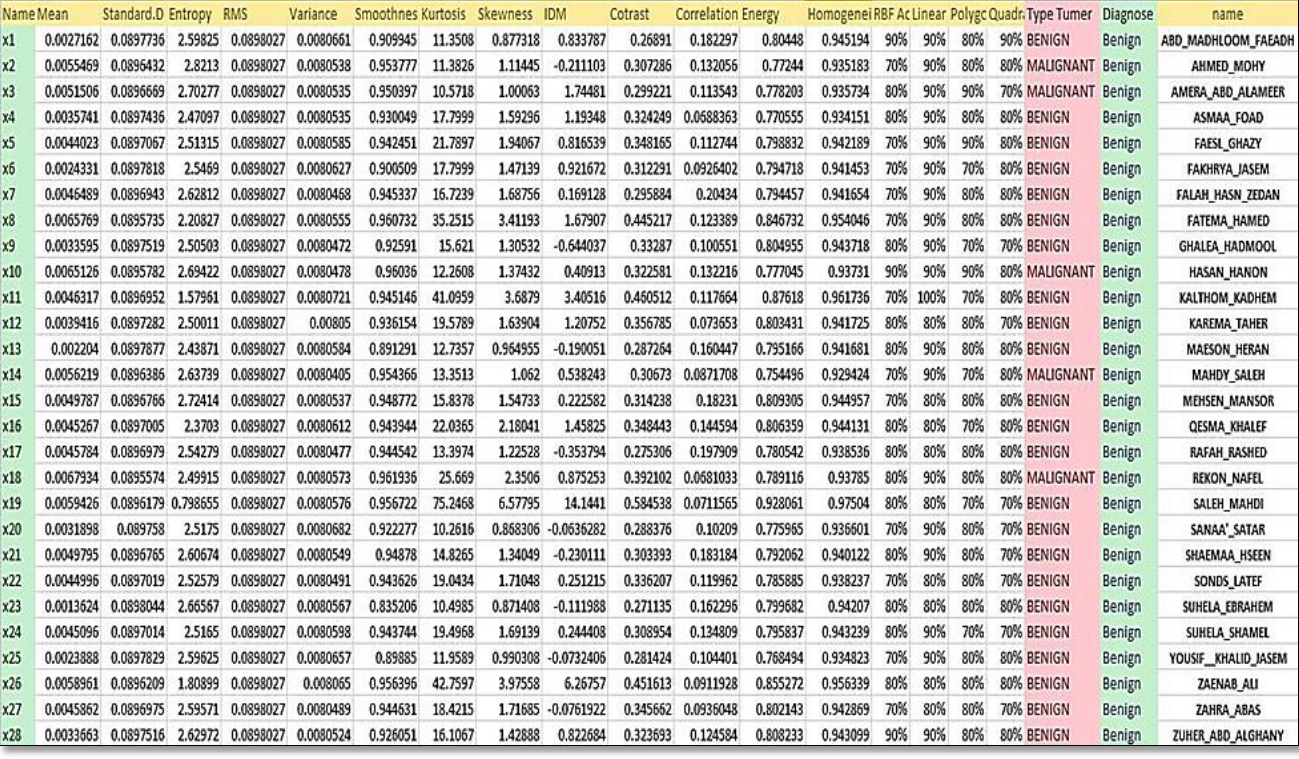
Table 1: Statistical characteristics of images [11].